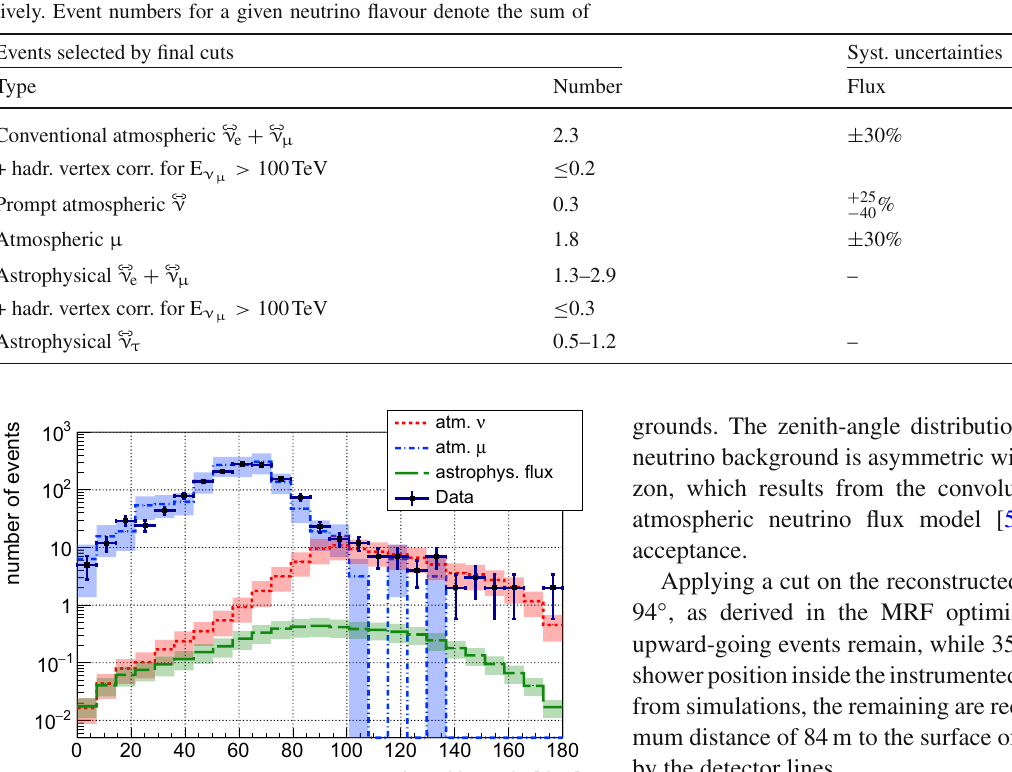
neutrinos and their respective antineutrinos. Additionally, the assumed systematicuncertaintiesonthefluxes,anduncertaintiesonthedetection efficiency, as inferred from detector simulations after the vertex-quality cut only (cf. Sect. 4), are shown